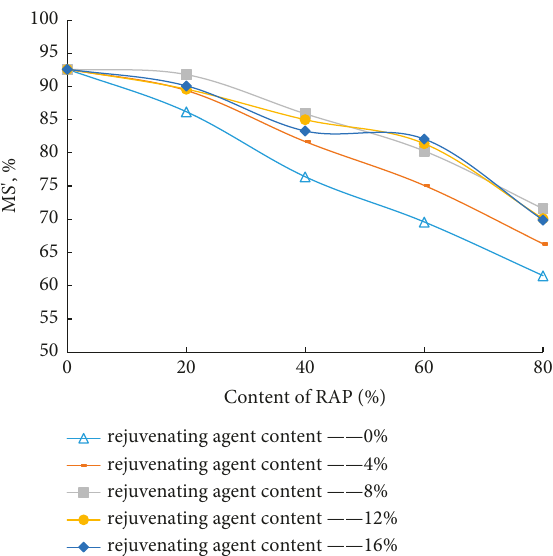
Figure 5: DS test results with different content of